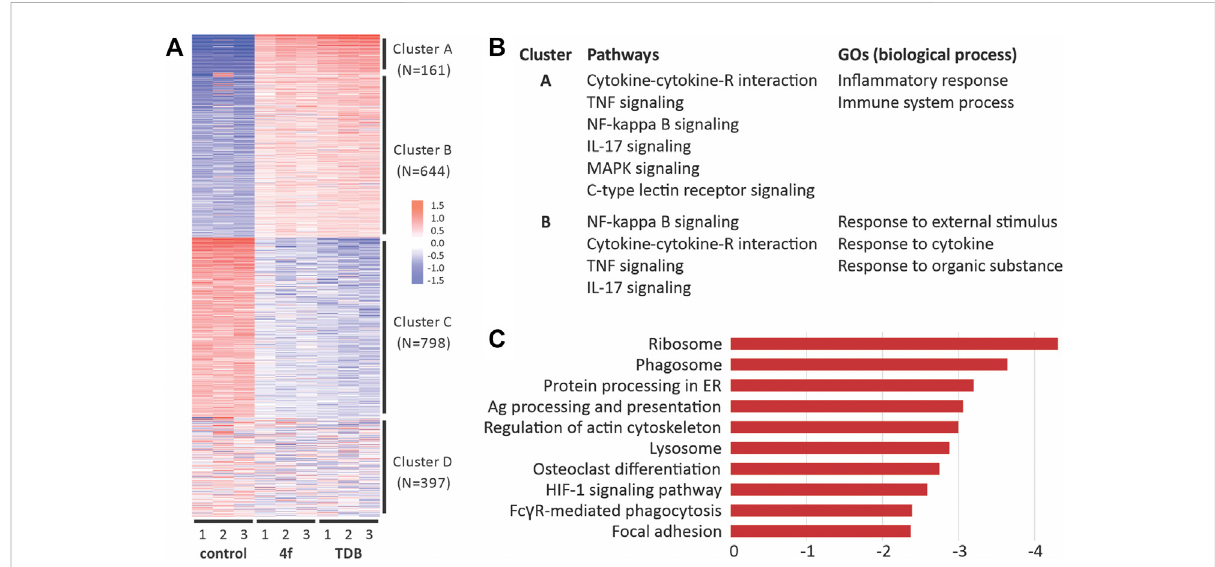
FIGURE 6 RNA-Seq analysis of gene pathway following the activation of GM-CSF treated BMCs with 4f and TDB reveals similarities in immune cell signaling but also differences in phagocytic pathways. (A) . Hierarchical clustering of differentially expressed genes. (B) . Functional enrichment of differentially expressed genes (DEGs) in response to 4f and TDB. (C) . KEGG pathway enrichment analysis showing the top 10 down-regulated pathways between 4f vs TDB control